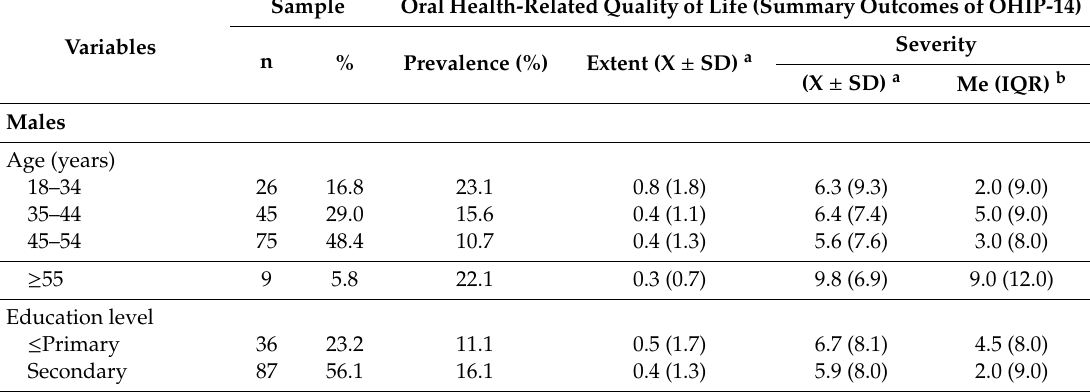
Table 2. Summary outcomes of the OHIP-14 as a proxy of oral health-related quality of life by sociodemographic variables in the PELFI cohort, Spain (n =